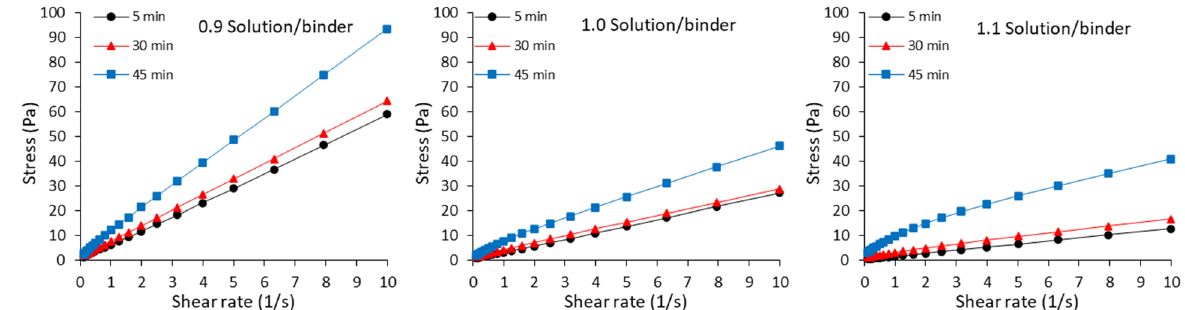
Figure 6. Flow sweep curve for pastes at different SiO 2 /Na 2 O ratios.